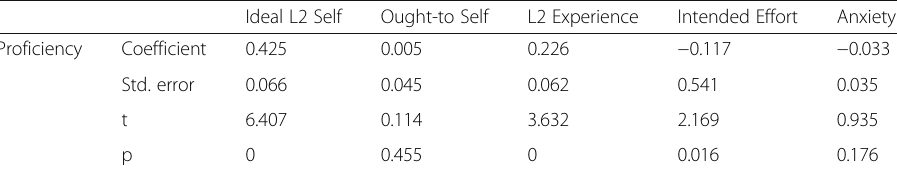
Table 5 Second regression